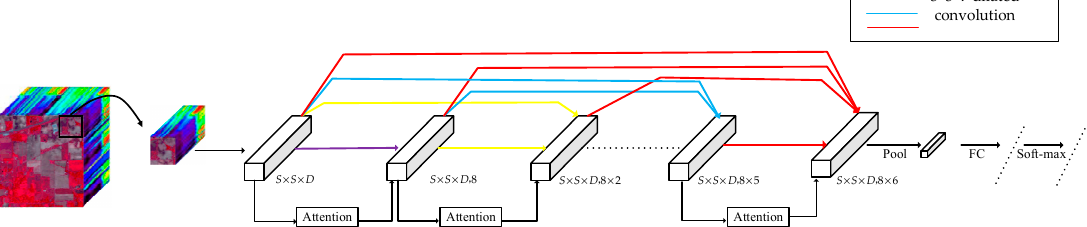
Figure 2. Proposed framework for HSI classification. The colored lines in the convolutional layers represent 3 × 3 × 7 dilated convolutions, with each color representing a different channel through layers of different dilation .